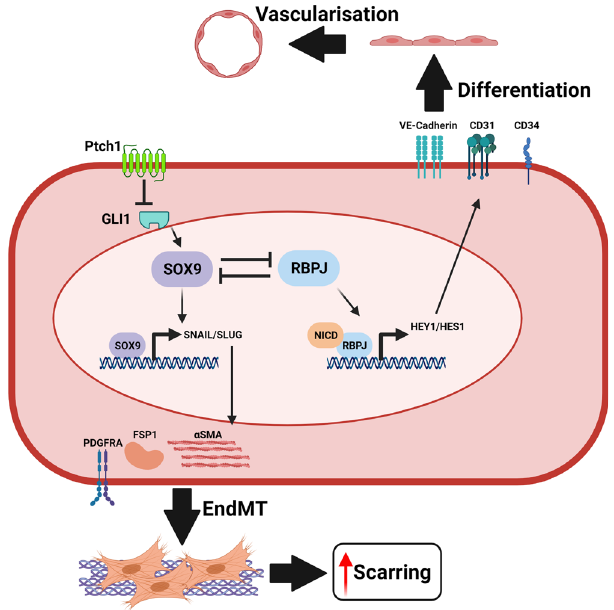
Fig. 9 Regulation of endovascular progenitors cell fate. The fate of EVPs is maintained by the co-inhibitory relationship between SOX9 and RBPJ maintained in a progenitor state in homoeostasis. However, increased expression of SOX9, either through the loss of RBPJ, or activation of the hedgehog pathway results in the translation of SNAIL and SLUG, driving the expression of mesenchymal-related factors such as FSP1, α SMA and PDGFRA. Thus, triggering EndMT and excessive scar formation. Conversely, the deletion of SOX9 promotes Notch signalling and RBPJ activities, favouring endothelial differentiation and